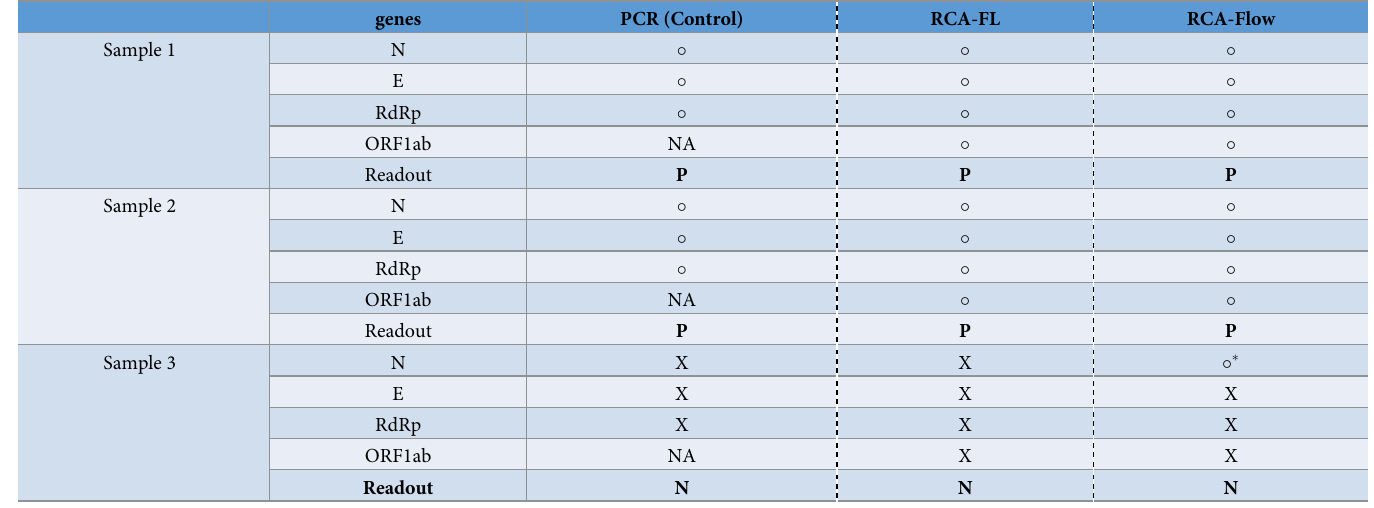
Table 1. Fluorescence and microchip results for various genes of SARS-CoV-2 and compared with commercialized